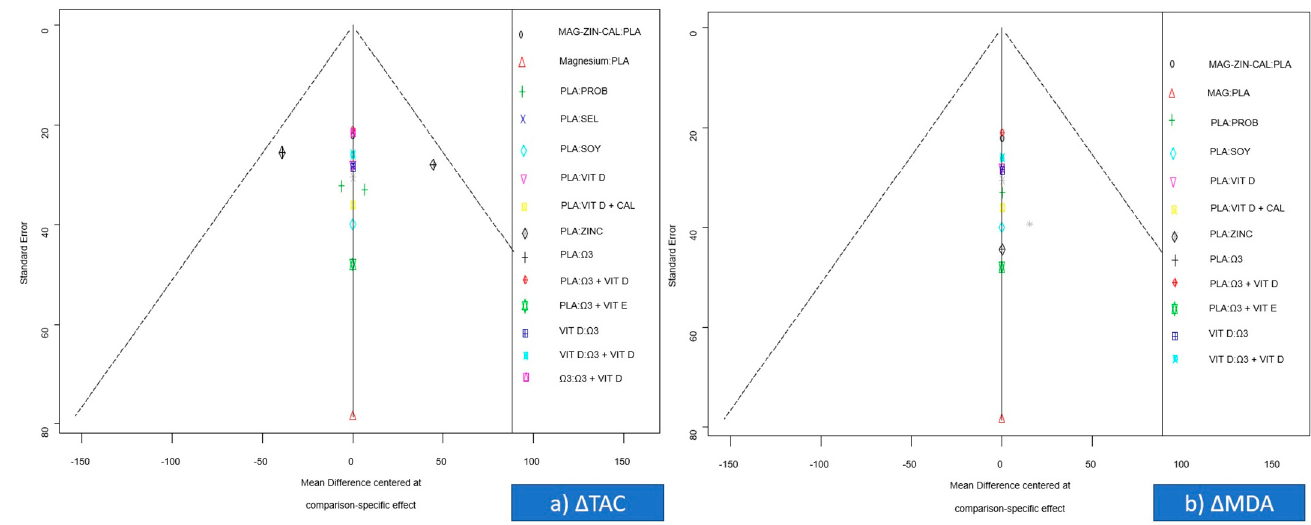
Figure 5. Comparison adjusted funnel plot of the included studies for the primary outcomes of ( a ) Δ TAC (changes in total antioxidant capacity) and ( b ) Δ MDA (changes in malondialdehyde).